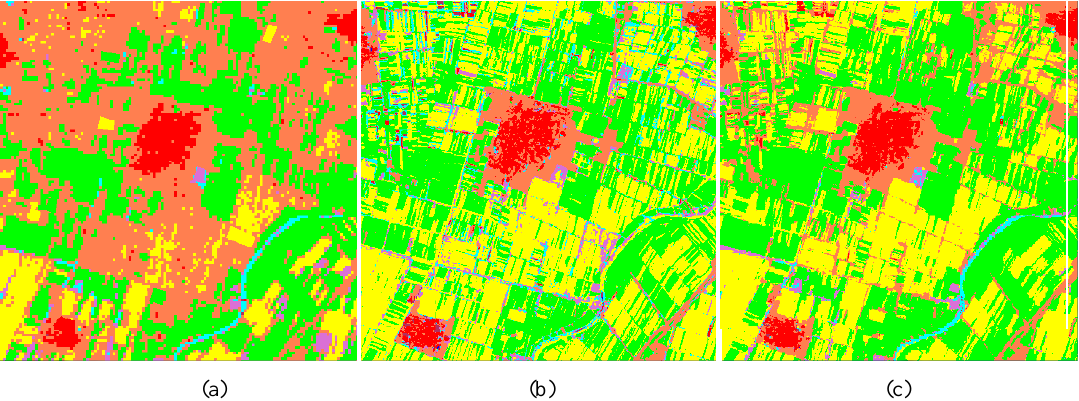
Figure 2 Portions of land cover classification results using difference data combinations for Hengshui area: (a) ETM+ data alone; (b) SPOT 5 alone; (c) Combined ETM+ and SPOT 5 data using